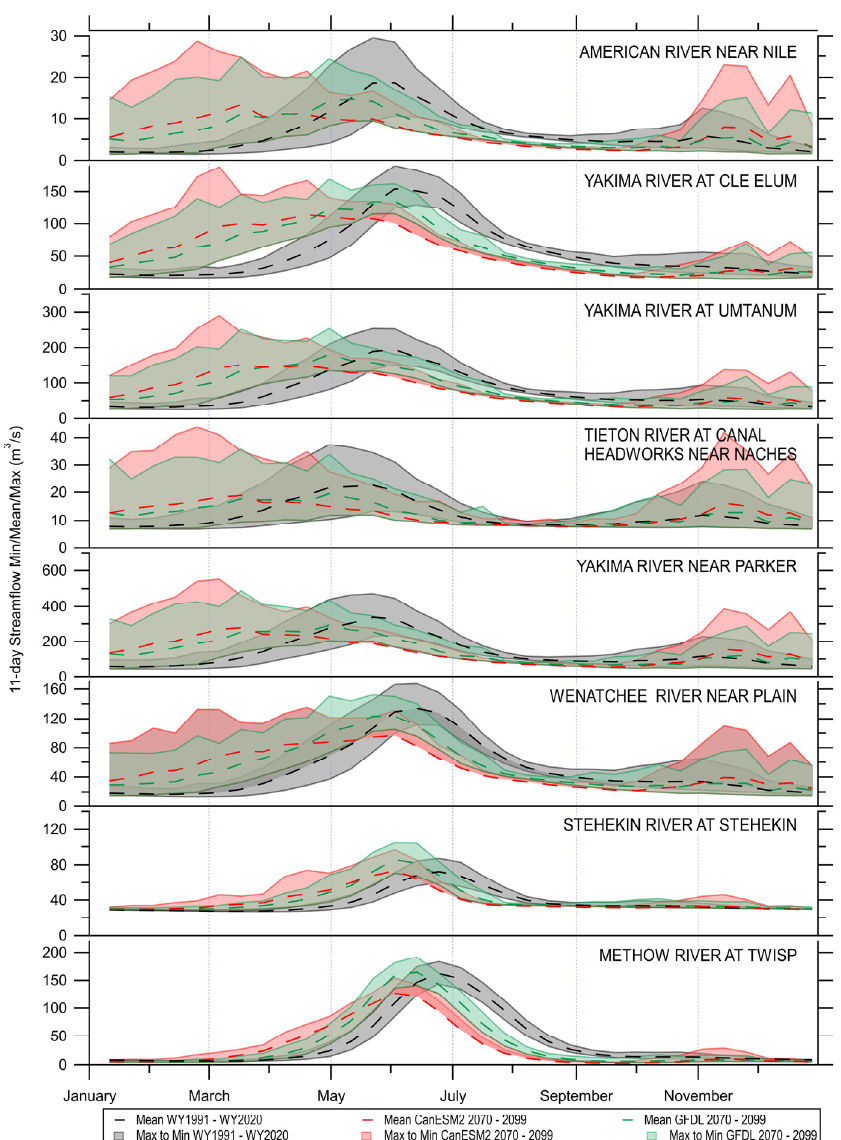
Figure 6. Streamflow trends for the eight USGS stations. Over the 109 year period, minimum streamflow trends are projected to decrease significantly in summer and fall at almost all stations with the exception of Tieton River and Stehekin River, where only small declines are projected. Spring minimum